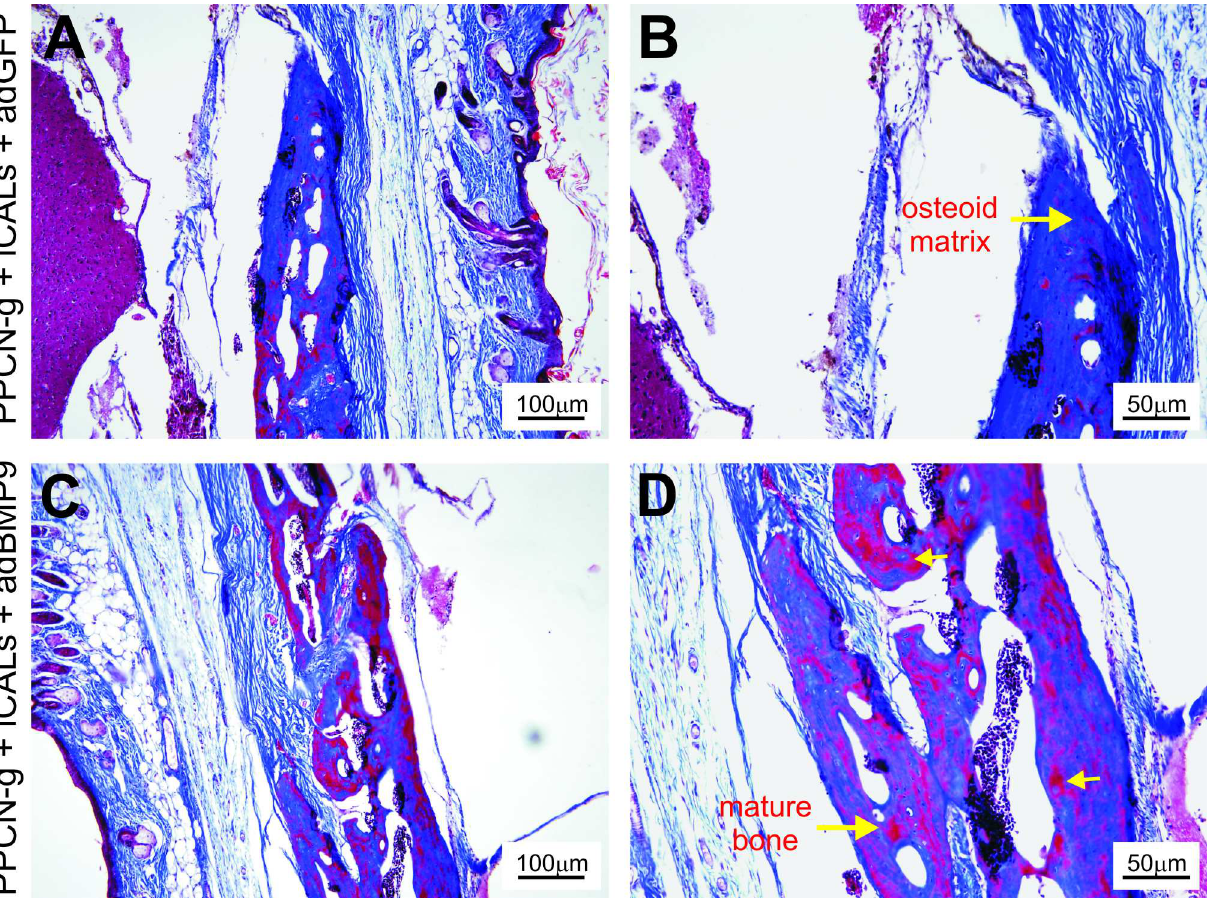
Fig 5. Assessment of the Trichrome histology. Histologic analysisof tissue microsections harvested12 weeks post-treatment. (A, B) Chondroid matrix and a smaller proportionof mature bone is shown in the defect site of a PPCN + iCAL + AdGFP-treated mouse. (C, D) A visibly higherproportionof mature bonecan be appreciated in samplestaken from the defect sites treated with PPCN + iCAL +